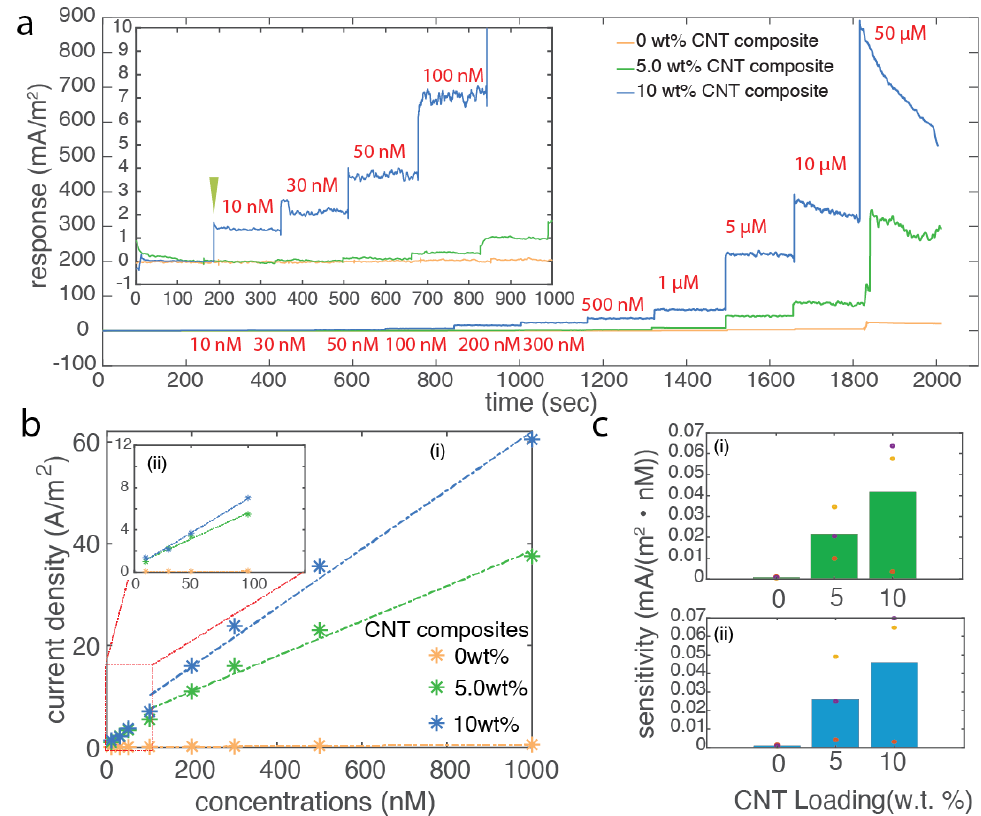
Figure 4. The DA sensing characterization of the CNT composite fiber. ( a ) Representative amper- ometry measurements of CNT composite fibers with DA sensing from 10 nM to 50 µ M. ( b ) The relationship of the averaged current density versus concentrations and the linear fitting of the re- sponse in different concentration ranges in ( i ) and ( ii ). ( c ) The calculated sensitivity of CNT composite fibers with different loading. Individual measurement is color coded. Concentration range: ( i ) 100 nM to 1 µ M and ( ii ) 10 to 100